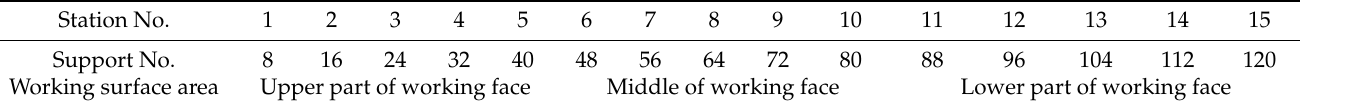
Table 3. Monitoring sub-station corresponding